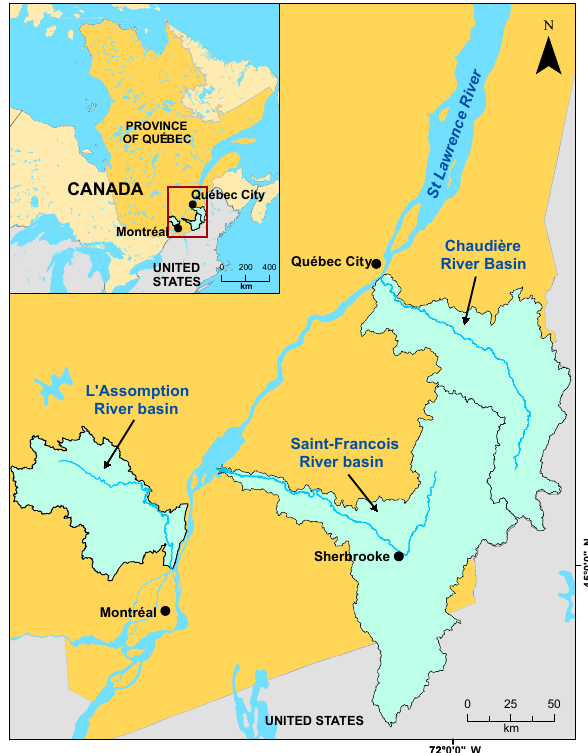
Figure 1. Location of the Chaudière River, Saint-François River, and L’Assomption River (province of Québec,